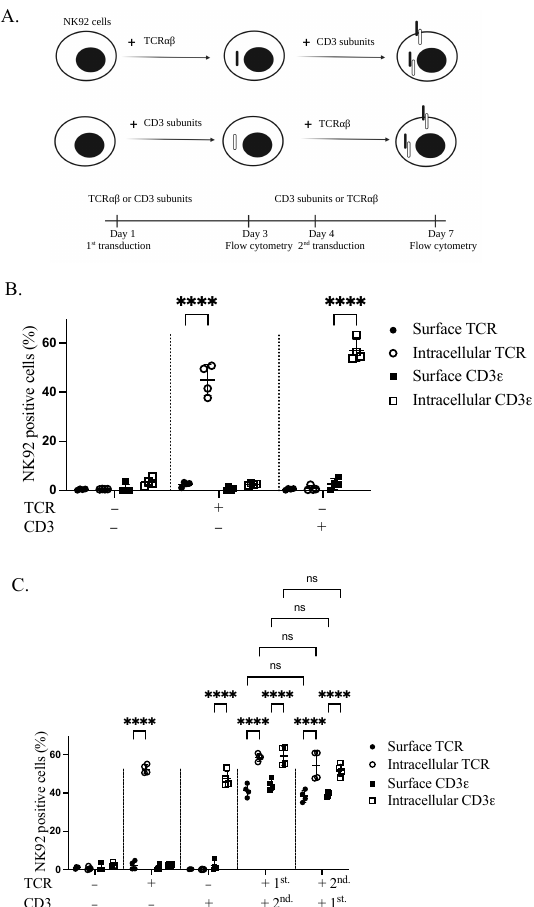
Figure 2. Transgenic TCR components are necessary to enable TCR complex expression on the cell membrane of NK92 cells. ( A ) Schematic overview of the sequential transductions and timeline. ( B ) Expression of TCR and CD3 alone in transduced NK92 cells. NK92 cells were transduced with either alpha/beta chains of TCR or CD3 subunits lentiviral vectors. Cells were collected and stained for flow cytometry three days after transduction. All cells were stained with TCR and CD3 ε antibodies and live cells were pre-gated. Two independent experiments were performed. ( C ) NK92 cells were transduced with either TCR αβ or CD3 subunits lentiviral vectors. On day four of transduction, whole TCR and CD3 transduced NK92 cell populations were transduced with CD3 subunits and TCR lentiviral vectors, respectively. Cells were harvested and stained for flow cytometry seven days after first transduction to see the expression of transgenes. All cells were stained with TCR β and CD3 ε antibodies and live cells were pre-gated. Two independent experiments were performed. ns indicates not significant. **** p <